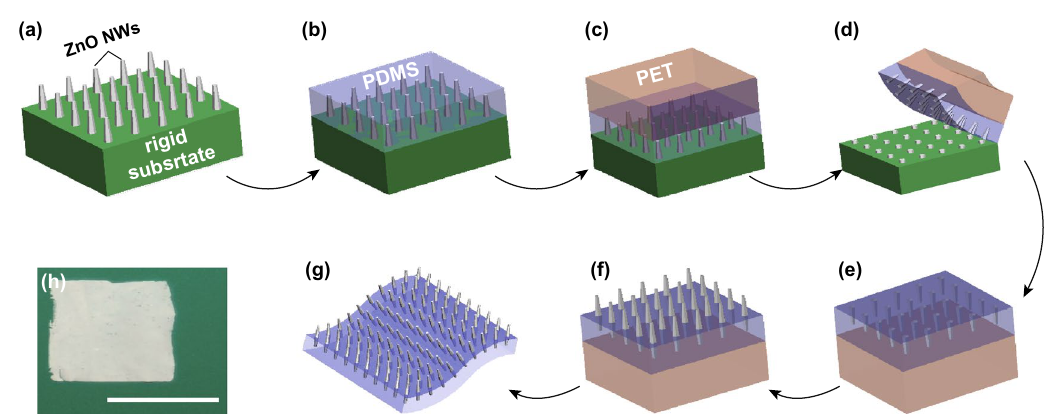
Fig. 1 Schematic of the proposed two-step fabrication process of the vertically aligned ZnO NW array on a polymer substrate. a A ZnO NW array was vertically grown on the glass slide via the hydrothermal synthesis. b A certain amount of a PDMS solution was spin-casted onto the ZnO NW array and thermally cured afterward. c A PET film was brought into intimate contact with the PDMS film. d The PDMS/PET stack was detached from the glass slide simultaneously. e The PDMS/PET layer became flat owing to the recovery of the PET film. f The ZnO NW array embedded in the PDMS film was regrown to a desired length via the same hydrothermal process. g The ZP film obtained after the PET film was removed from the PDMS film. h Photograph of the as-prepared ZP film (1 × 1 in. 2 ). Scale bar: 1